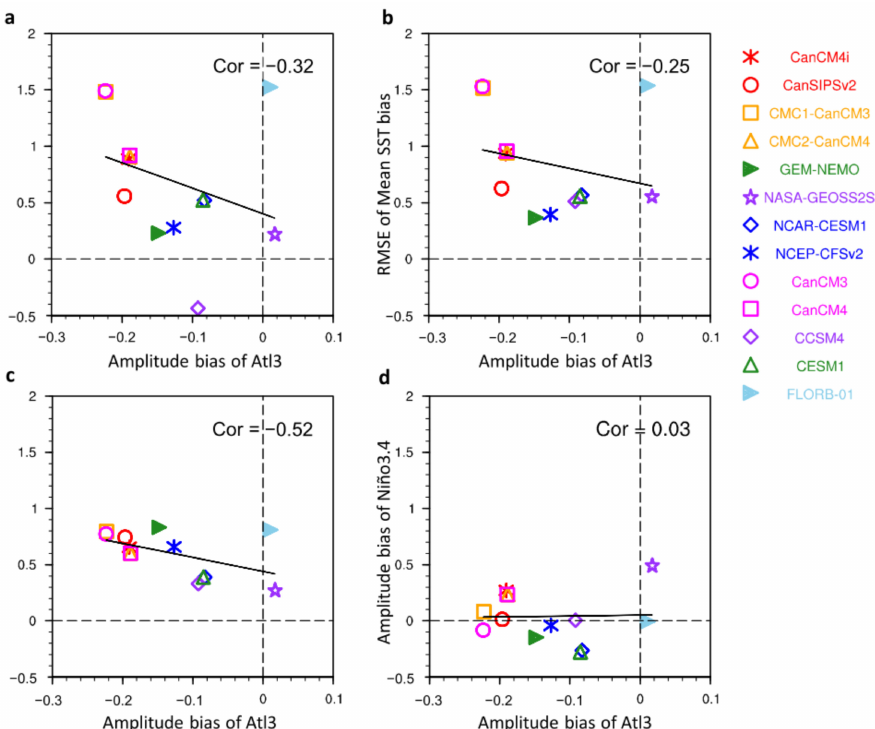
Figure 11. Scatter diagram showing the relationship between the amplitude bias of the predicted Atl3 index ( x -axis) and ( a ) mean SST bias averaged over Atl3 region, ( b ) the RMSE of mean SST biases averaged over Atl3 region, ( c ) the bias of the zonal gradient of mean SST, ( d ) the amplitude bias of the predicted Niño3.4 index (i.e., SST anomalies averaged for 5 ◦ S–5 ◦ N, 170 ◦ W–120 ◦ W). Here the amplitude bias of the predicted Atl3 index is measured by the difference between the STD of the predicated Atl3 index and the STD of the observed Atl3 index (i.e., model forecast minus observation). The bias of zonal gradient of mean SST is represented by mean SST bias averaged over the Atl3 region subtracting that in the western equatorial Atlantic (3 ◦ S–3 ◦ N, 40 ◦ W–20 ◦ W). The linear regression line is presented in the figure and the correlation coefficient is shown on the top right of each panel. Note that the relationship shown here are derived from the three-month-lead forecast, which resemble those at different lead